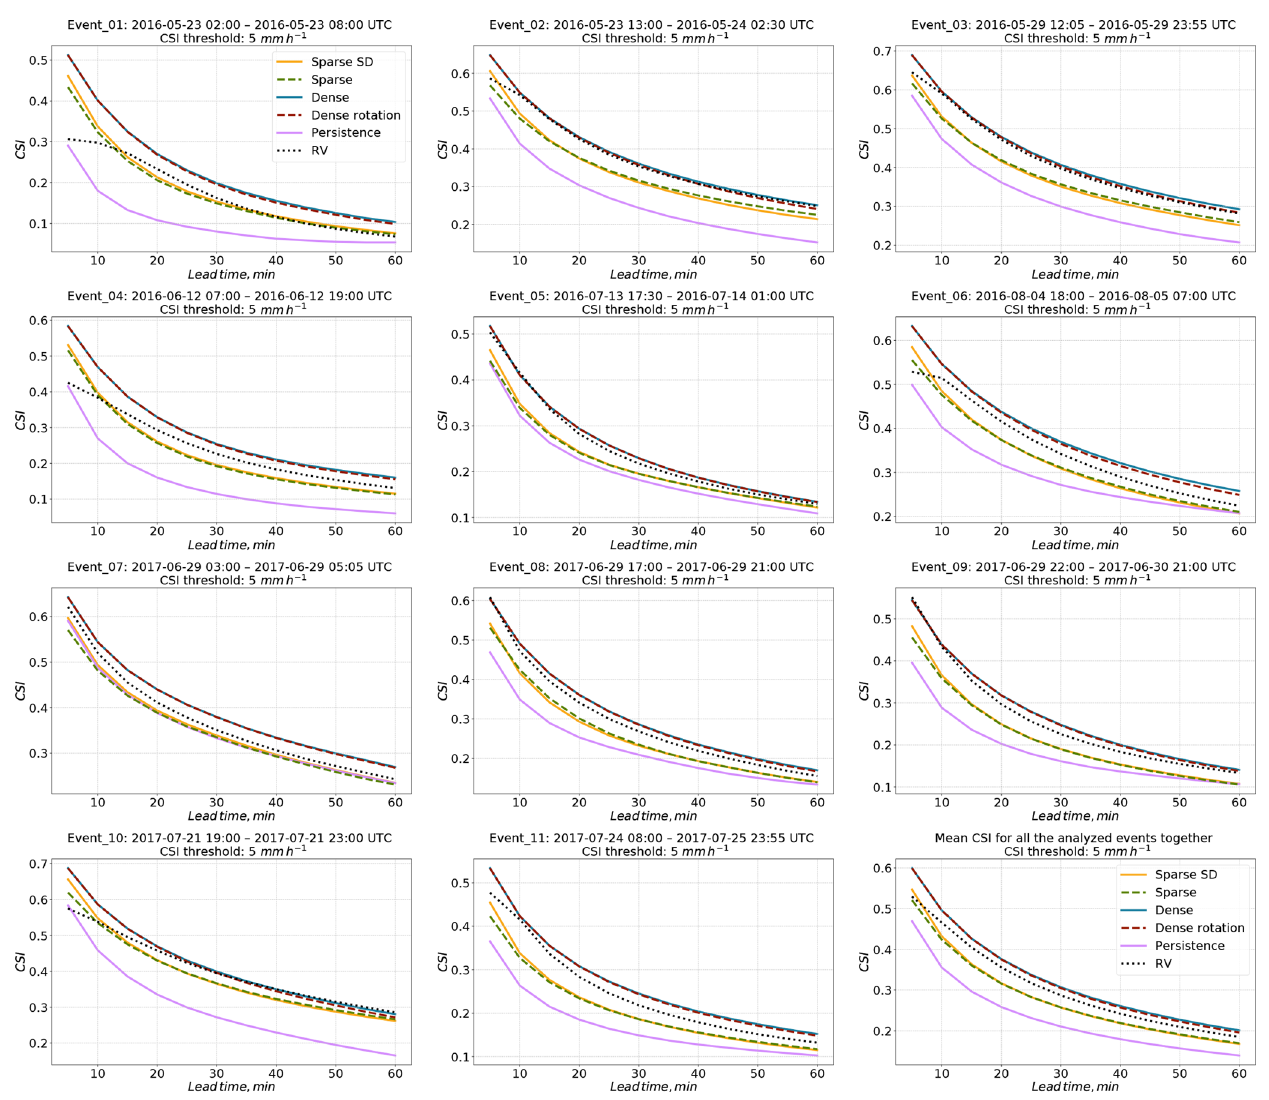
Figure 8. Verification of the different optical flow based nowcasts in terms of CSI for the threshold of 5mmh − 1 for 11 precipitation events over